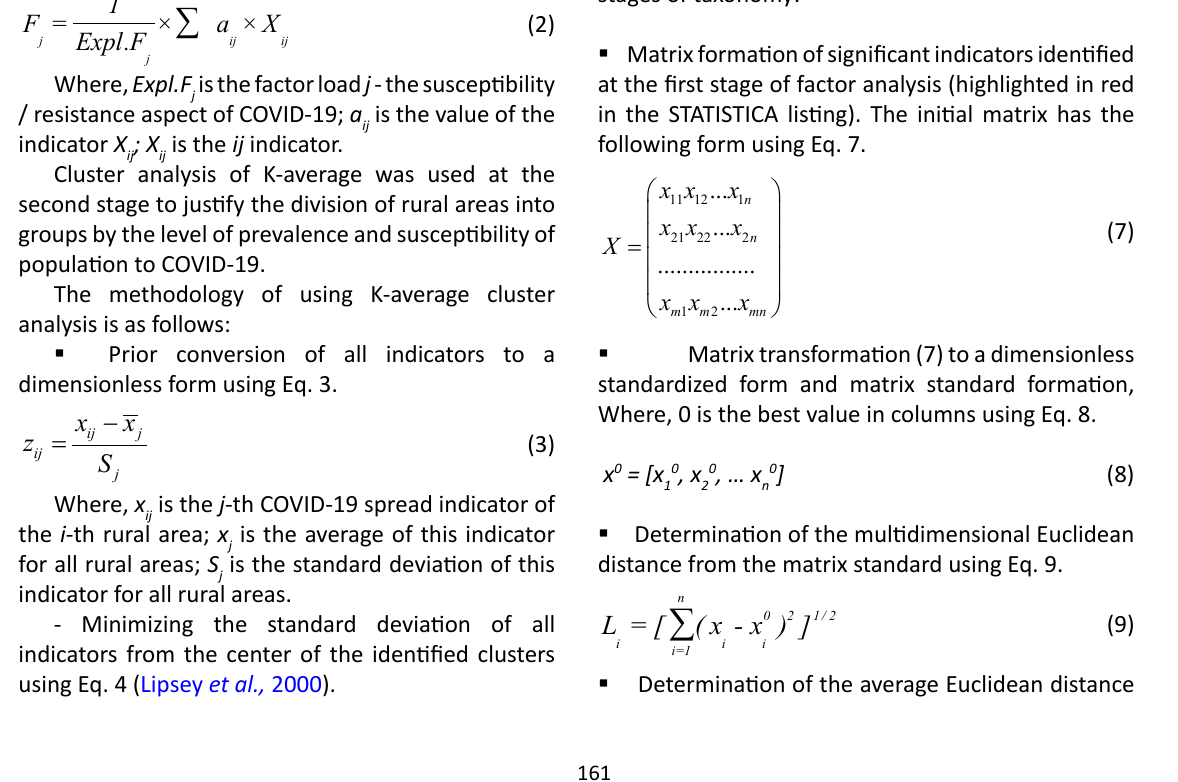
Determination of the average Euclidean